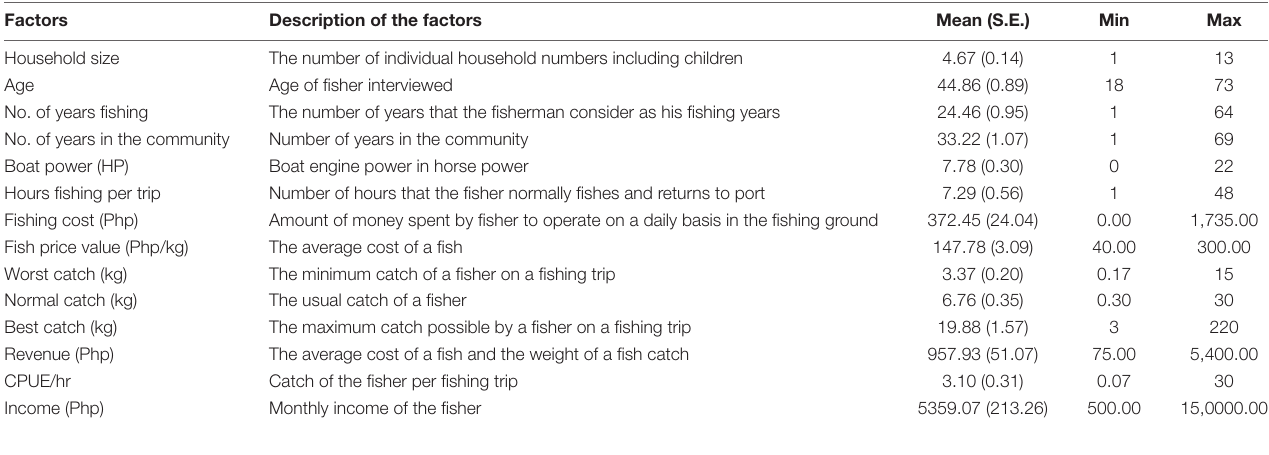
TABLE 1 | Sociodemographic profile of the respondents including a brief